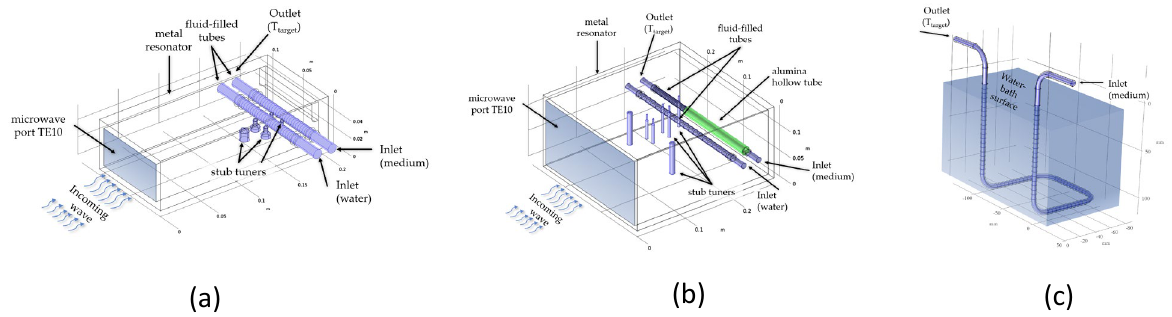
Figure 2. Microwave heating units within the closed-loop system: ( a ) 2.45 GHz microwave heating unit and ( b ) self-designed 915 MHz microwave heating for microwave heating (MH). Both microwave heating units have TE10 ports, two horizontally aligned quartz-glass tubes, one for the cell suspension (rear tube), and one as variable dummy absorber (front tube). In addition, stub tuners are used for optimizing and controlling the electromagnetic energy absorption of the cell suspension; ( c ) cooling is achieved by a stainless-steel loop immersed into a controllable water-bath.